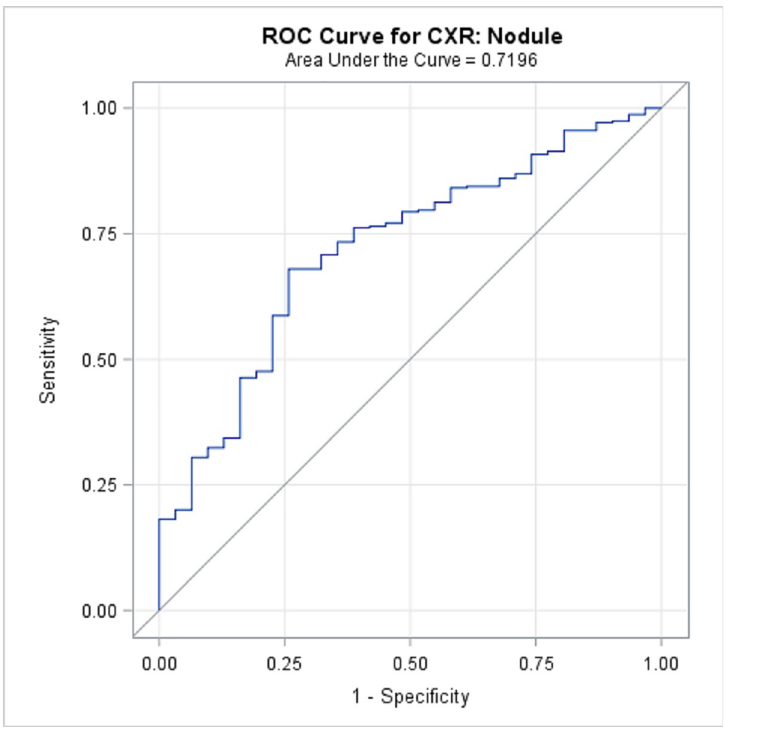
Fig 5. ROC Curve for CXR: Nodule.